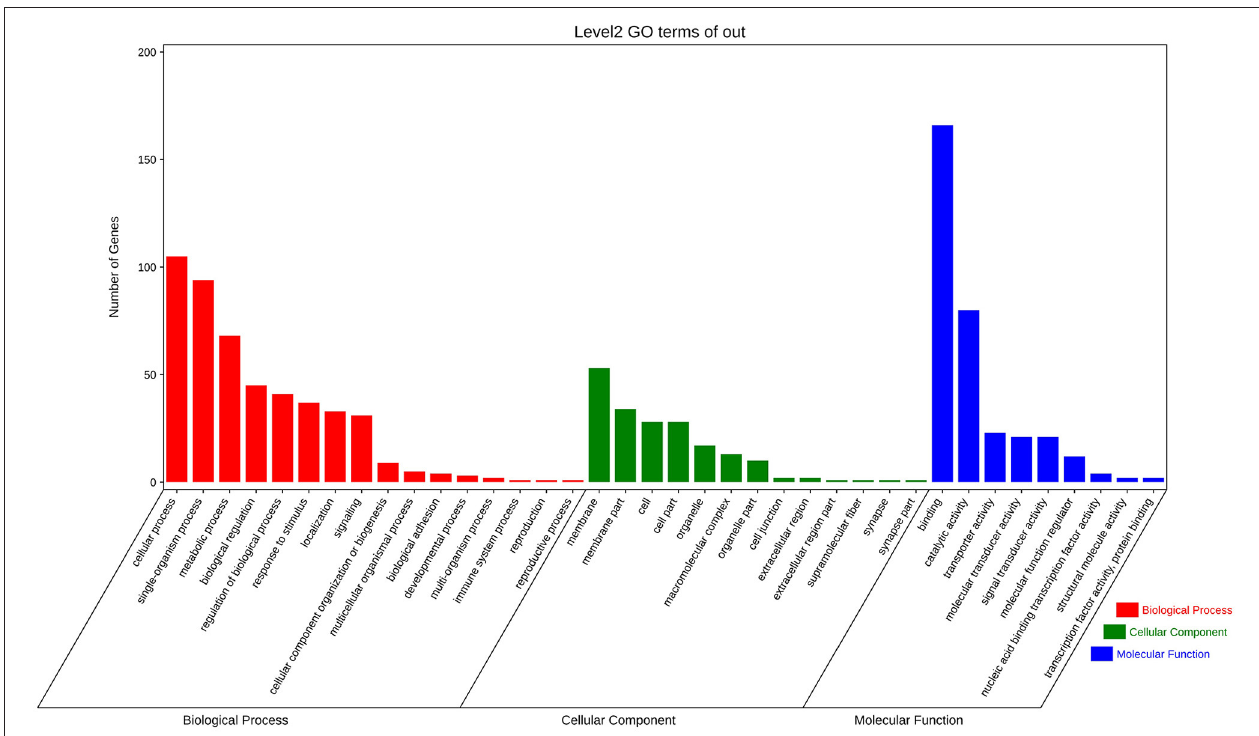
FIGURE 4 | The summary of Gene Ontology (GO) function annotation analysis for candidate genes that comprised significant SNPs ( p < 1.00E − 5). Each term describes the function of the gene cluster, and the length of colored bars represents the difference of the number of